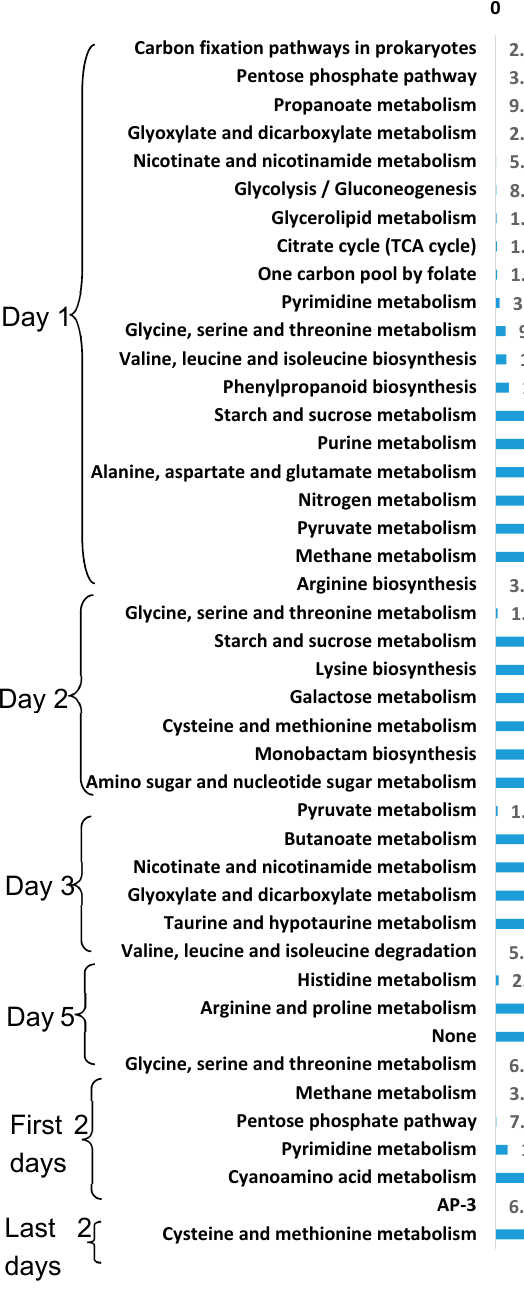
Figure 6. Enriched pathways of specifically active reactions in each day. The vertical axis represents enriched pathways, and the horizontal axis represents the p -value of enrich analysis of each pathway. To further explore the relationship among cysteine and methionine metabolism, cell growth, and AP-3 production, we simulated the biosynthetic velocity of key metabolites in methionine biosynthesis and tricarboxylic acid cycle (TCA cycle), as shown in Figure 7. The biosynthetic velocity of citrate in the first day was significantly higher than that in other days, while the velocity of